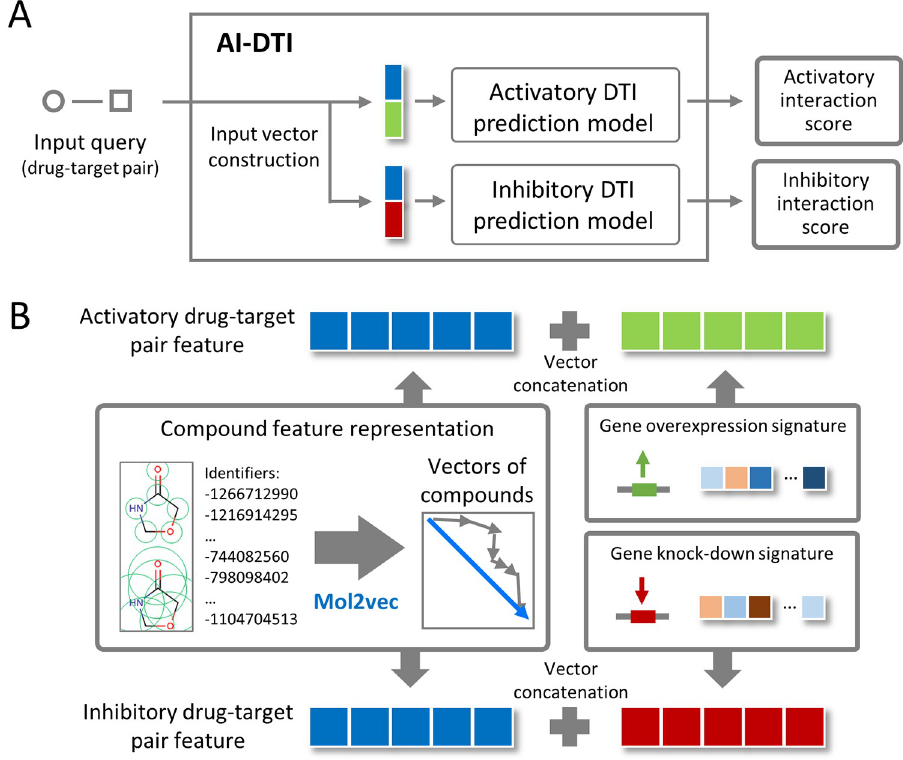
Fig 1. Overview of the AI-DTI pipeline. (A) A structure of AI-DTI. (B) Feature vector generation for activatory and inhibitory drug-target interactions (DTIs). For activatory DTIs, the feature vector was represented as a concatenation of the compound vector and aggregated gene overexpression signatures. For inhibitory DTIs, the feature vector was represented as a concatenation of the compound vector and aggregated gene knockdown signatures.